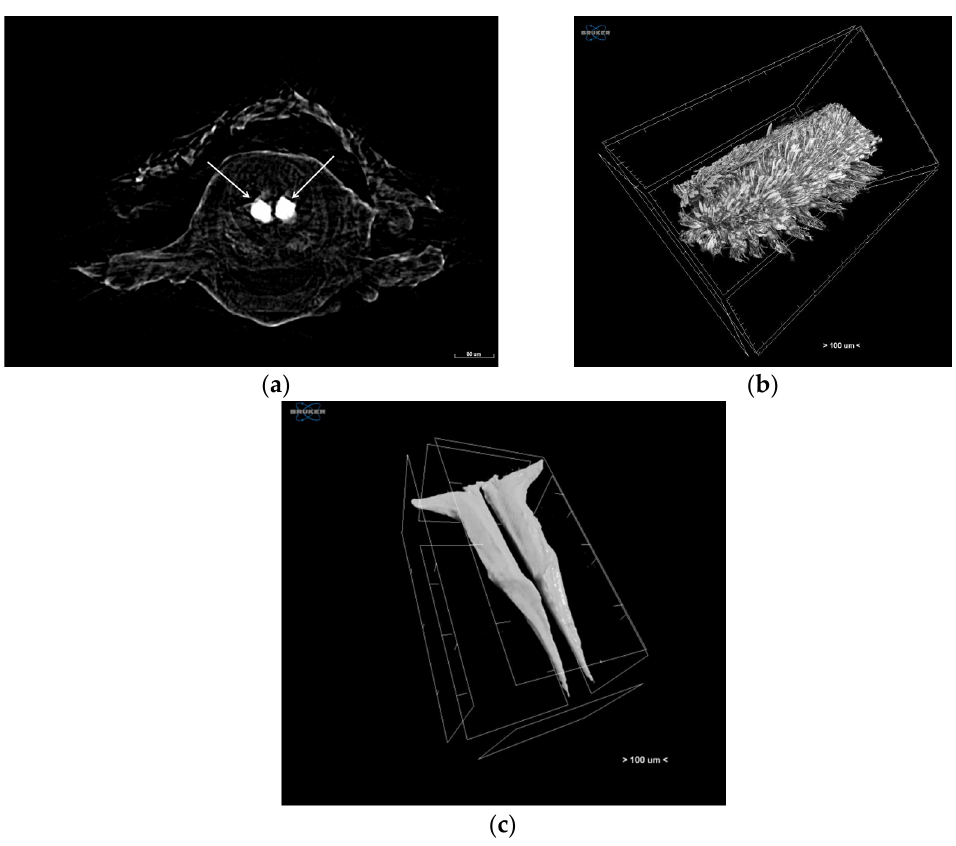
Figure 8. Micro-CT images of ( a ) cross-section of the middle body of specimen, with white arrows showing the jaws, ( b ) body shape of the specimen, and ( c ) jaws of the specimen.